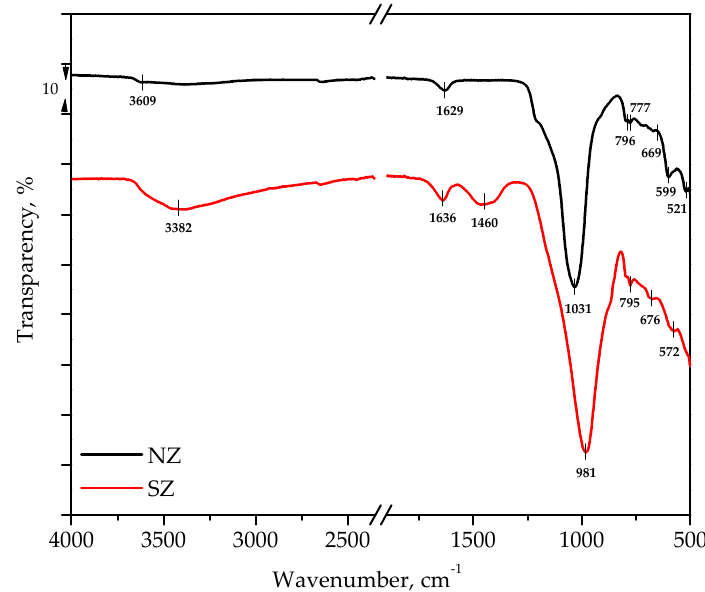
Figure 9. FTIR spectra of NZ and SZ.